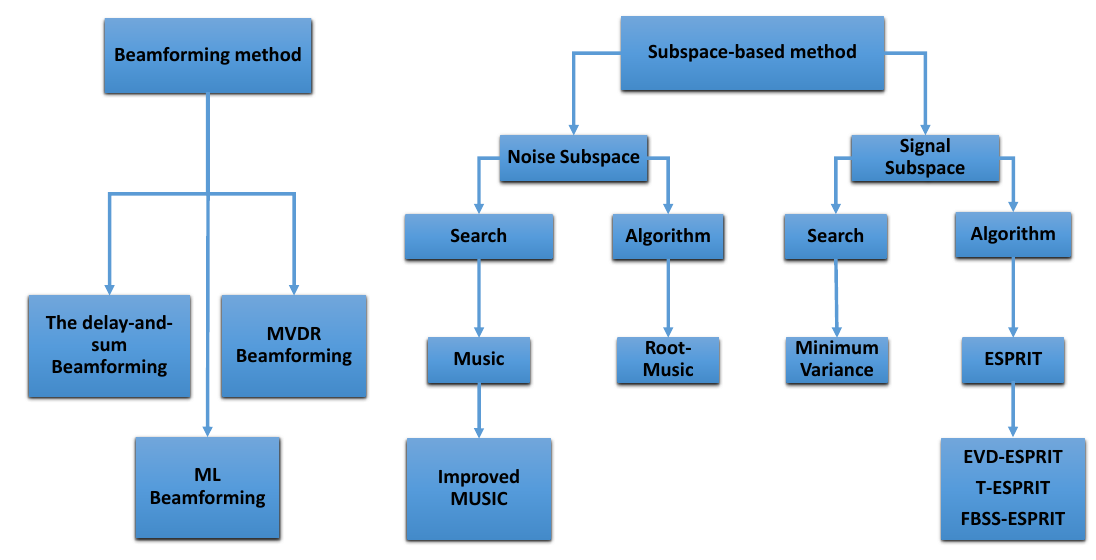
Figure 10. Type of DoA beamforming and subspace